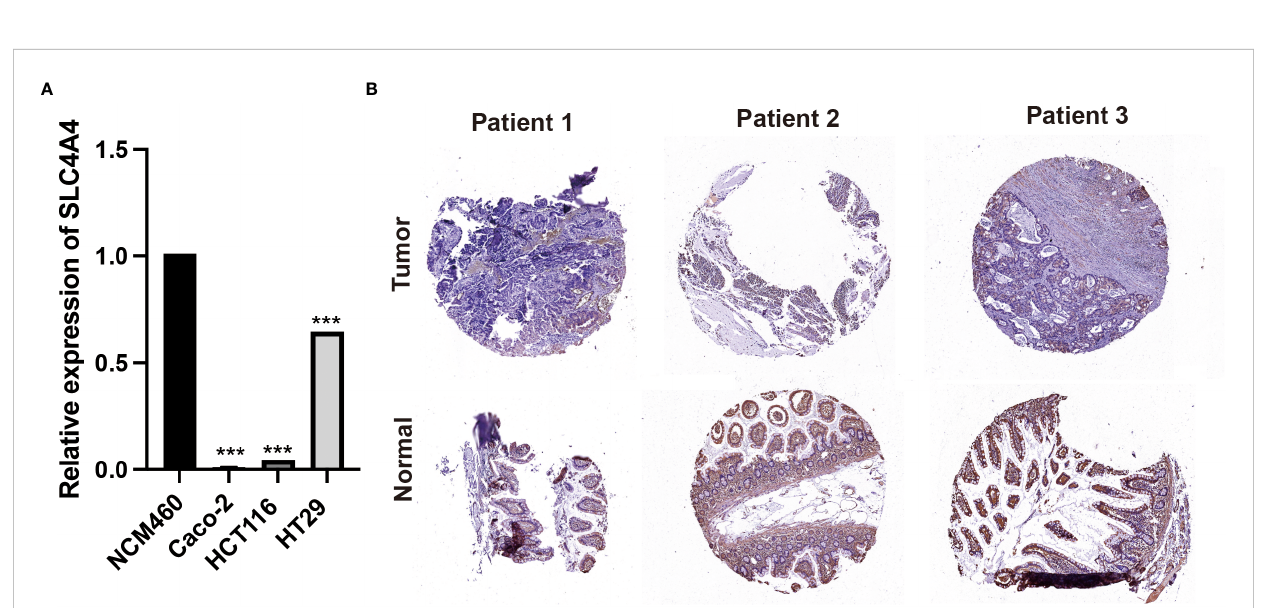
FIGURE 8 Experimental veri fi cation of SLC4A4 . (A) PCR experiments in cell lines. SLC4A4 was signi fi cantly down-regulated in colorectal cancer cell lines Caco-2, HCT116 and HT29 (***P<0.001). (B) Immunohistochemical examination of 3 clinical samples. The expression of SLC4A4 is low in tumor